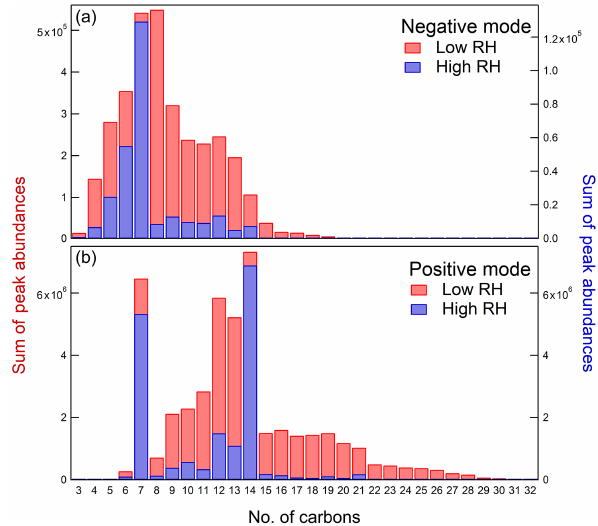
Figure 2. Combined abundance of all peaks as a function of the number of carbon atoms in negative mode (a) and positive mode (b) . The data for the low-RH sample are shown in red and the data for the high-RH sample are shown in blue. The samples were prepared under low-NO x